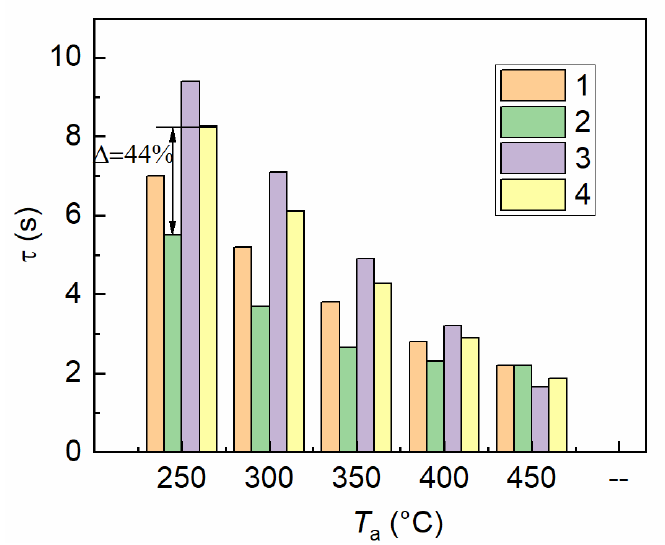
Figure 10. Comparison of droplet (15 µL) heating times for various compositions to explosive breakup versus gas temperature (using the results [103]): 1—emulsion (97% water, 3% petroleum); 2—emulsion (95% water, 5% petroleum); 3—emulsion (97% water, 3% oil); 4—emulsion (95% water, 5% oil).